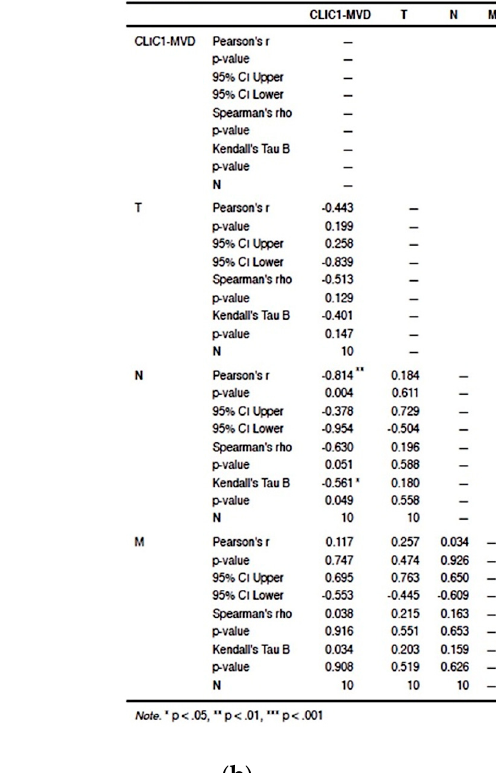
Figure 1. Statistical analysis results ( a ) and correlation plot ( b ) for Class 0 cases related to the TNM staging parameters. No significant correlation was recorded between CLIC1-MVD and T, N, or M parameters. A strong significant correlation has been observed between the N and M parameters, suggesting that CLIC1-MVD may favor nodal and distant metastasis.